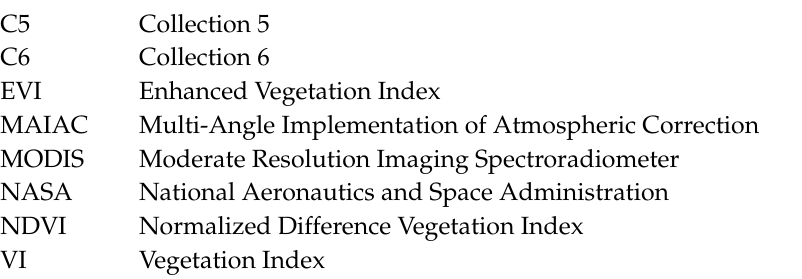
years from 2000 to 2012. Gray shaded areas are areas with missing data; Figure S9: Spatial patterns of standardized anomalies of dry-season Collection 6 EVI over Amazon in the